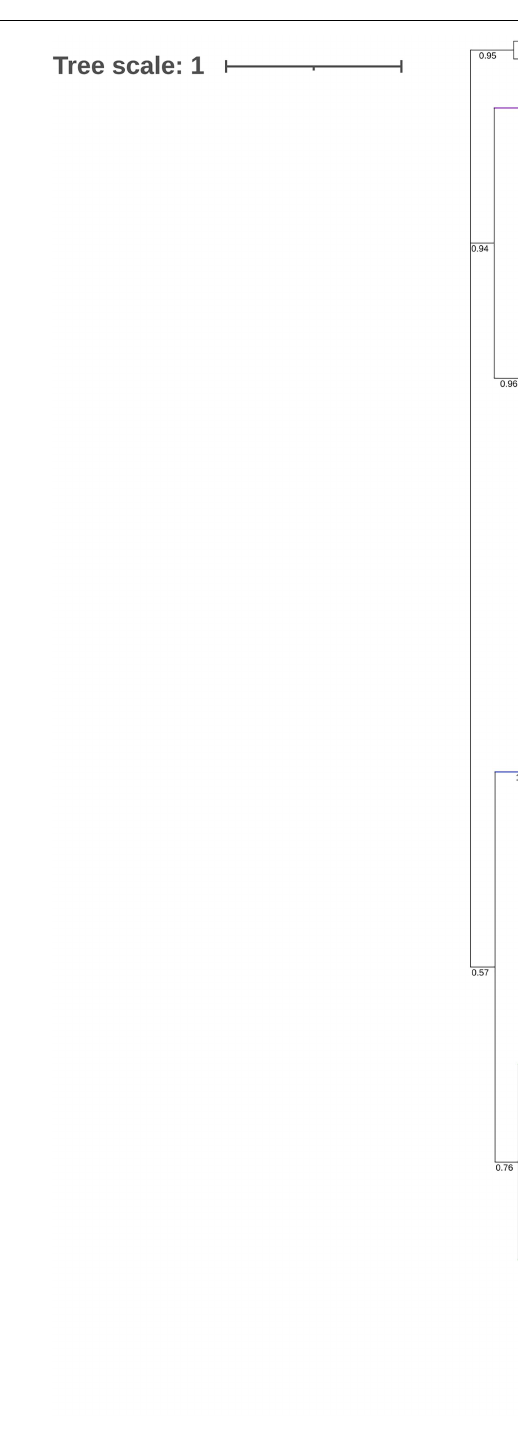
FIGURE 3 | Phylogenetic tree of the DNA polymerase B sequences. The analysis was performed using the Maximum Likelihood method (ML) with a JTT substitution matrix in 1,000 replicates. Branch values lower than a bootstrap value of 0.5 were deleted. Colors were assigned for different group of viruses: blue for Mimiviruses and extended Mimiviridae ; green for Pandoraviruses, Mollivirus sibericum, Emiliania huxleyi viruses (light green) and Phycodnaviridae (dark green); purple for groups of Asfarviridae , Faustoviruses, Pacmanvirus, and Kaumoabevirus; gray for Marseilleviridae; red for Orpheovirus, Solumvirus, Solivirus, Cedratviruses, and Pithovirus sibericum; and orange for Iridoviridae . Clandestinovirus is highlighted in bold and italic.